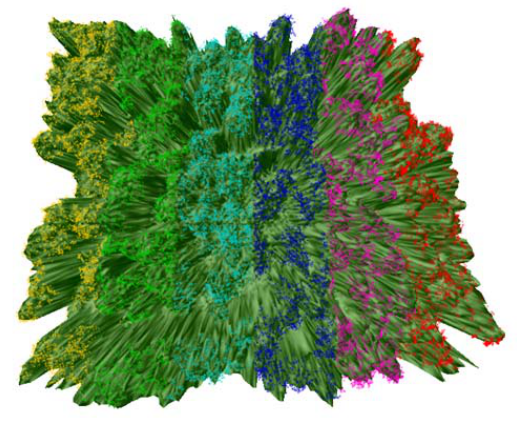
Figure 1. LIDAR raw data overlaid on DSM.